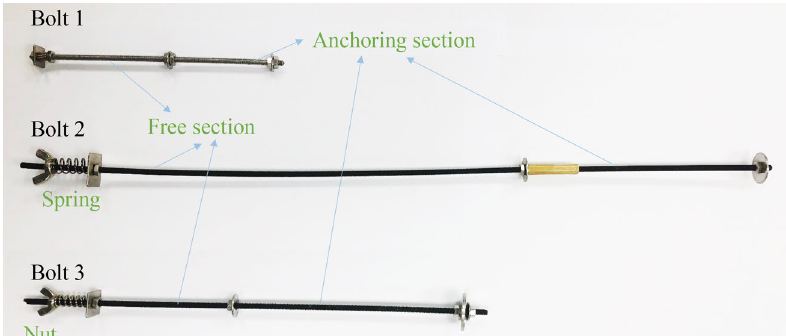
Figure 3. Experimental